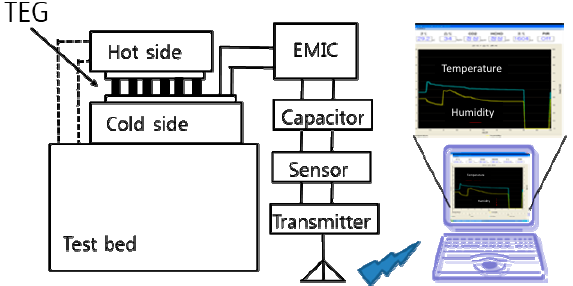
Figure 1. The proposed wireless sensor node system for environmental monitoring application with temperature and humidity sensor.